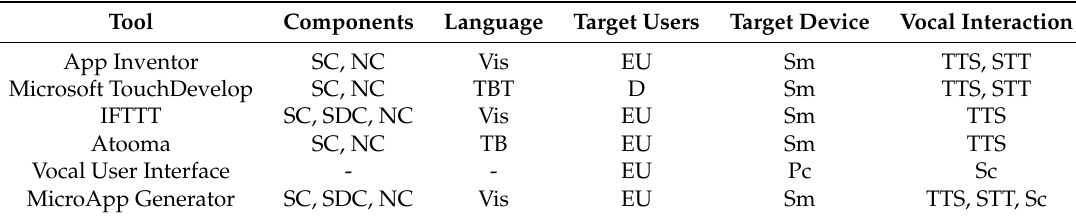
Table 1. Technological features of related works and tools.